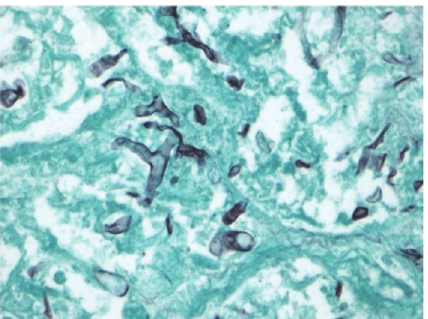
Figure 3: Grocott-Gomori methenamine-silver (GMS) stained tissue section of resected lung from an 18-year-old with recent kidney transplant highlighting aseptate hyphae morphologically resembling fungal class Zygomycetes (400x).